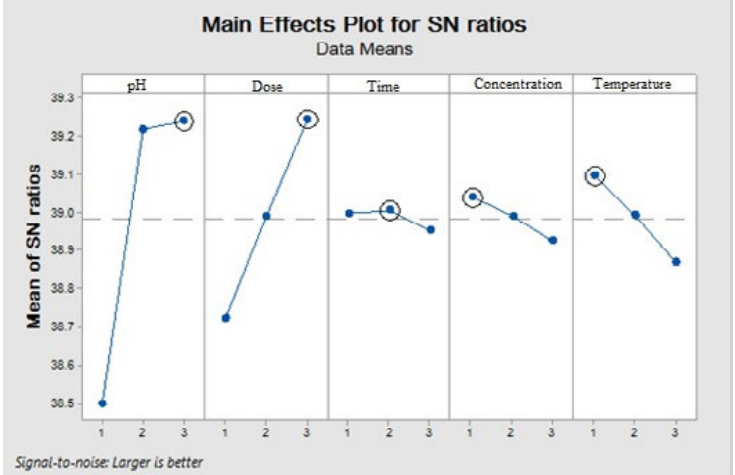
Fig. 4. FTIR spectrum of (a) Raw M (b) activated carbon and (c) Fe Figure 5. The variation of S/N ratio of different factors